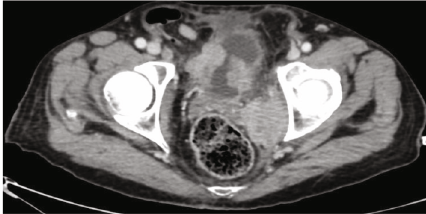
Figure 7: Pelvic scan showing the evolution of the bladder